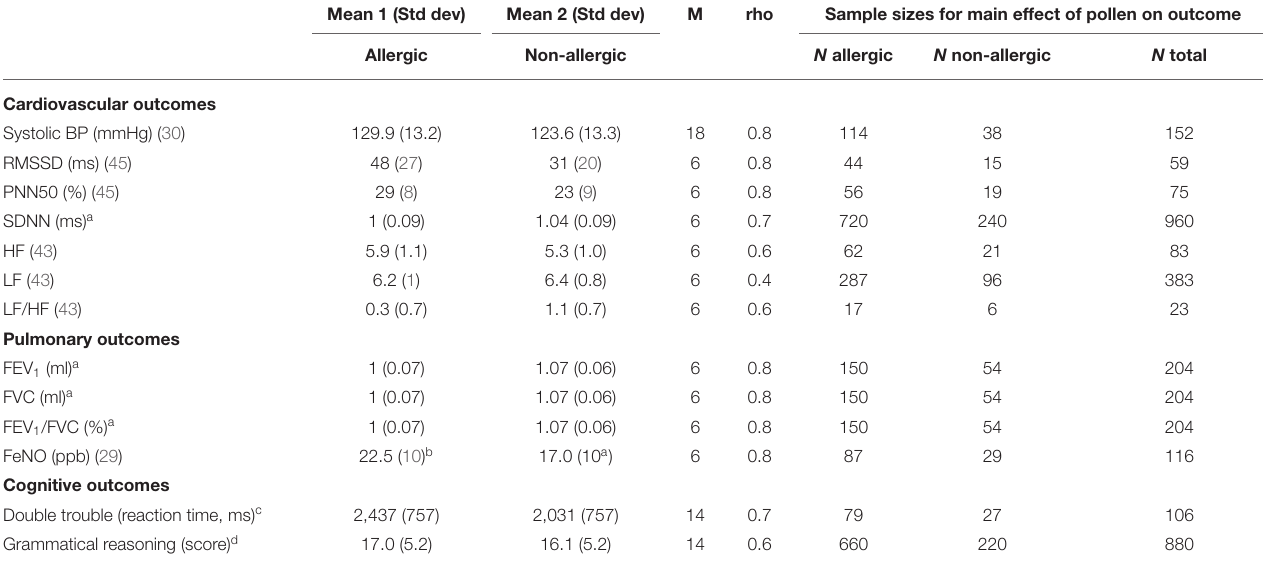
TABLE 2 | Sample size calculations for cardiovascular, pulmonary and cognitive outcomes. Mean 1 (Std dev) Mean 2 (Std dev) M rho Sample sizes for main effect of pollen on